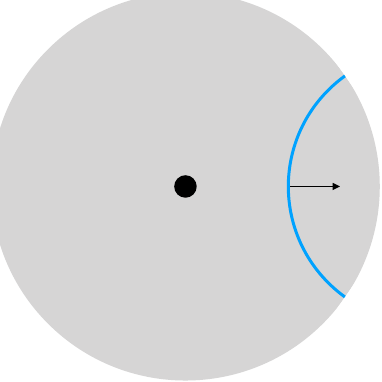
Figure 2 . A particle on the hyperbolic disk. We indicate the centrifugal force (which is always repulsive).